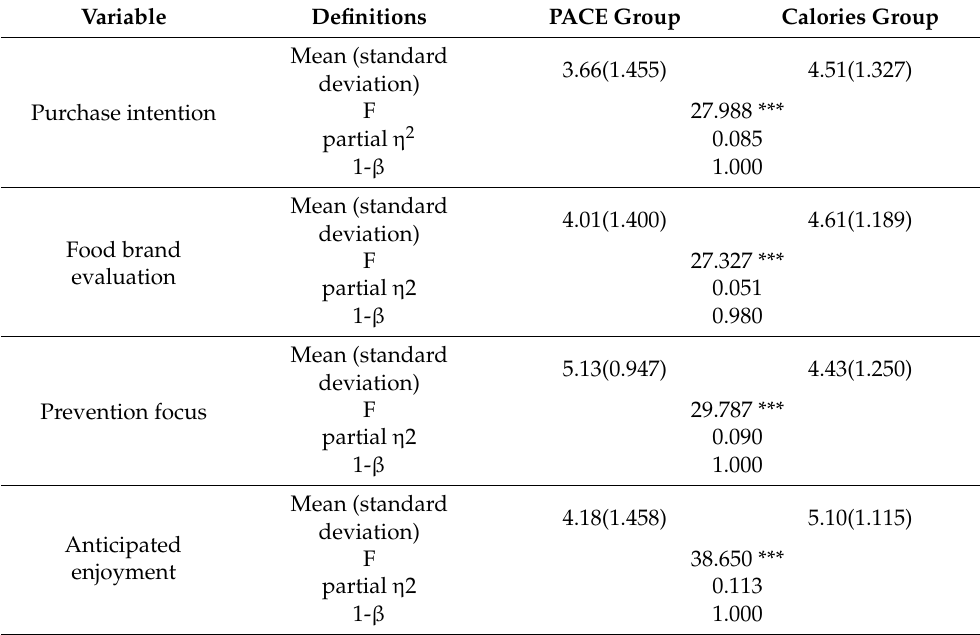
Table 3. Main results of Study